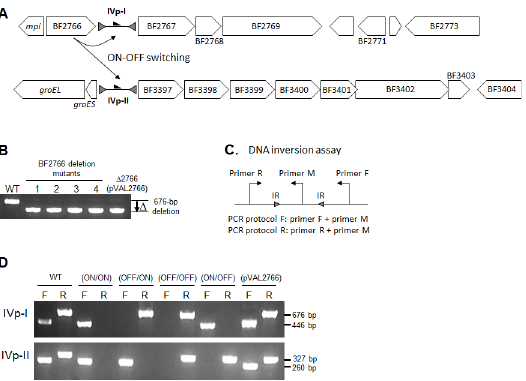
Fig 1. Genetic disruption of BF2766 to lock the IVp-I/IVp-II orientation. (A) An open-reading-frame map of the regions containing the BF2766-regulated invertible promoters IVp-I and IVp-II. The mpi gene encodes a master recombinase that controls seven PS promoter inversions. The genes downstream of IVp-I (BF2767-BF2769) are associated with extracellular polysaccharide production. IVp-II is located just upstream of the seven-gene cluster (BF3397-BF3403). The IVp-II orientation does not influence the transcription of the upstream groES / EL chaperonin genes. Detailed information about the genes shown in this panel is summarized in S1 Table. Gray arrowheads: inverted repeat sequences (IRs). Black arrowheads: promoter orientation. (B) PCR-based confirmation of a 676-bp internal deletion of BF2766. The four mutants with different genotypic combinations of IVp-I/IVp-II orientation were used for the following analyses. (C) Schematic of the primer design to detect IVp-I/IVp-II orientations. (D) BF2766 mutants showing the different IVp-I/IVp-II-locked patterns. F and R indicate the primer pair shown in panel C. In a wild-type sample, PCRs with both the F and R primers produced bands of the expected size (indicated on the right side), showing that IVp-I/IVp-II promoter inversion occurs in vitro . The locked patterns of IVp-I/IVp-II in the BF2766 mutants are indicated above the lane. For example, ON/ON indicates that both promoters are locked ON relative to downstream genes. Plasmid complementation of the mutants with intact BF2766 restored IVp-I/IVp-II promoter inversion. The IVp-I OFF genotype was prevalent in the wild type, but plasmid complementation abrogated this